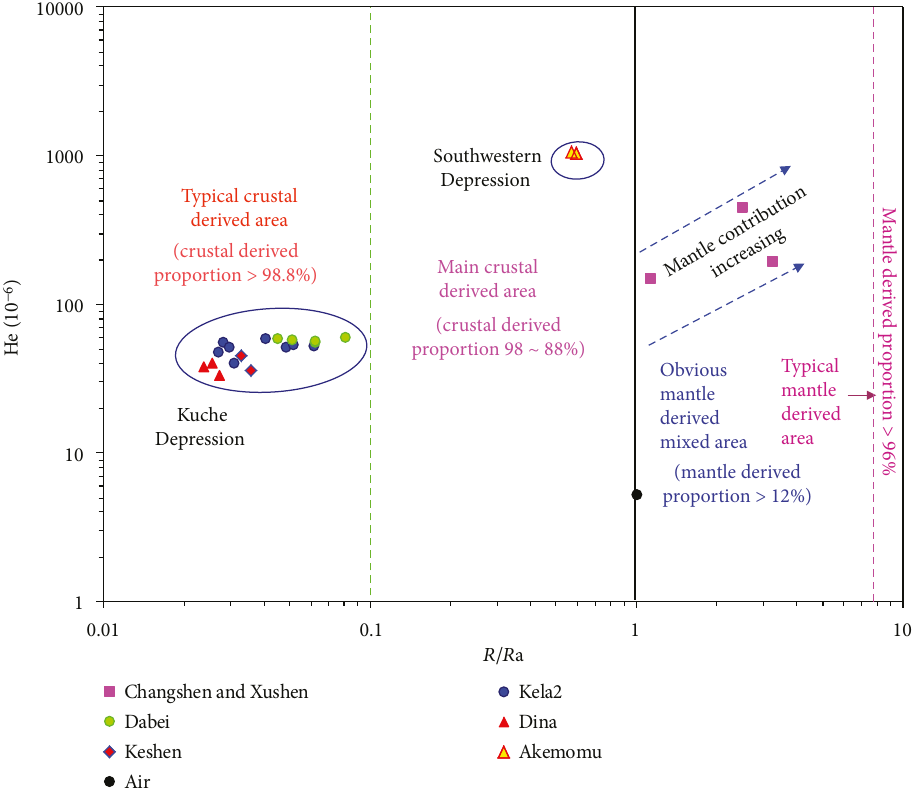
fi elds from the Kuche and Southwestern Depressions, Tarim Basin (chart modi fi ed a for some gas